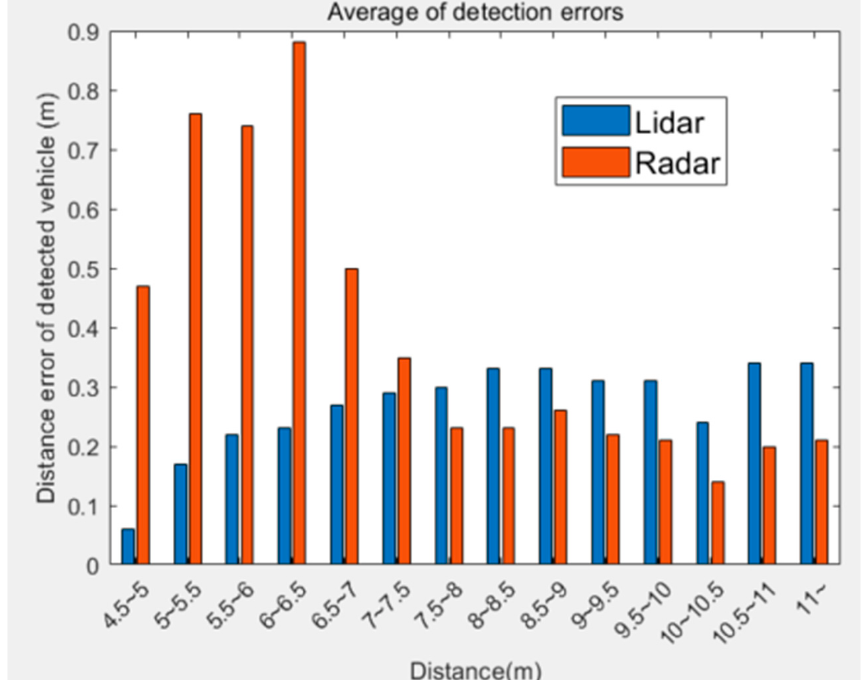
Figure 5. Measurement error lidar sensor and radar sensor according to distance.